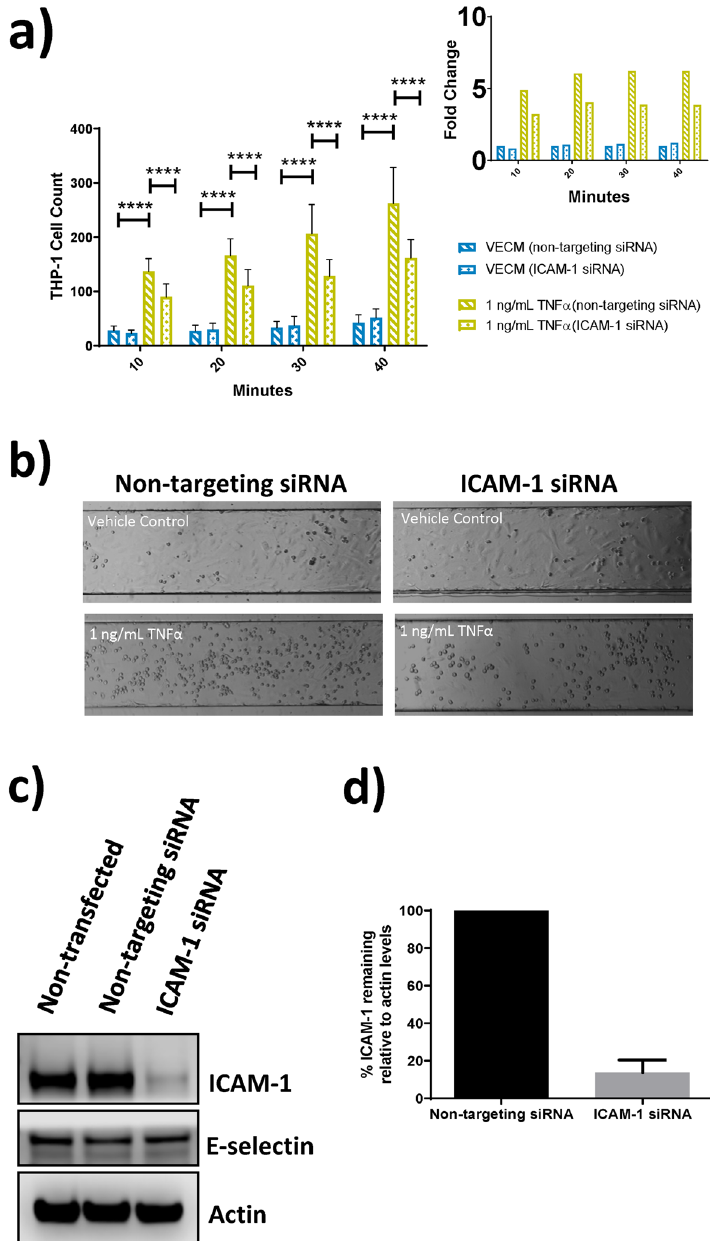
Figure 7. Analysis of ICAM-1 involvement in TNFα-induced monocyte adhesion to HAECs in the BioFlux microfluidic system. ( a ) Quantification of monocyte adhesion to HAECs over a course of adhesion periods (10, 20, 30 and 40 min) following transfection with control or ICAM-1 siRNA and 24 h HAEC exposure to 1 ng/mL TNFα in BioFlux microfluidic channels, with fold change graphs inset. ( b ) Representative brightfield images of BioFlux microfluidic channels captured after the 40 min adhesion period using a Zeiss Axio Observer.Z1 microscope (×10 magnification) following transfection with control or ICAM-1 siRNA and 24 h HAEC exposure to TNFα. ( c ) Western blot analysis of ICAM-1 and E-selectin levels following 72 h transfection of HAECs with control or ICAM-1 siRNA (refer to Supplementary Figure S1 for uncropped blots). ( d ) Quantification of ICAM-1 levels following 72 h transfection of HAECs with control or ICAM-1 siRNA. Two-way ANOVA with Dunnett’s multiple comparisons between vehicle all treatment conditions. Error bars denote ± SD (n = 22); ****p <